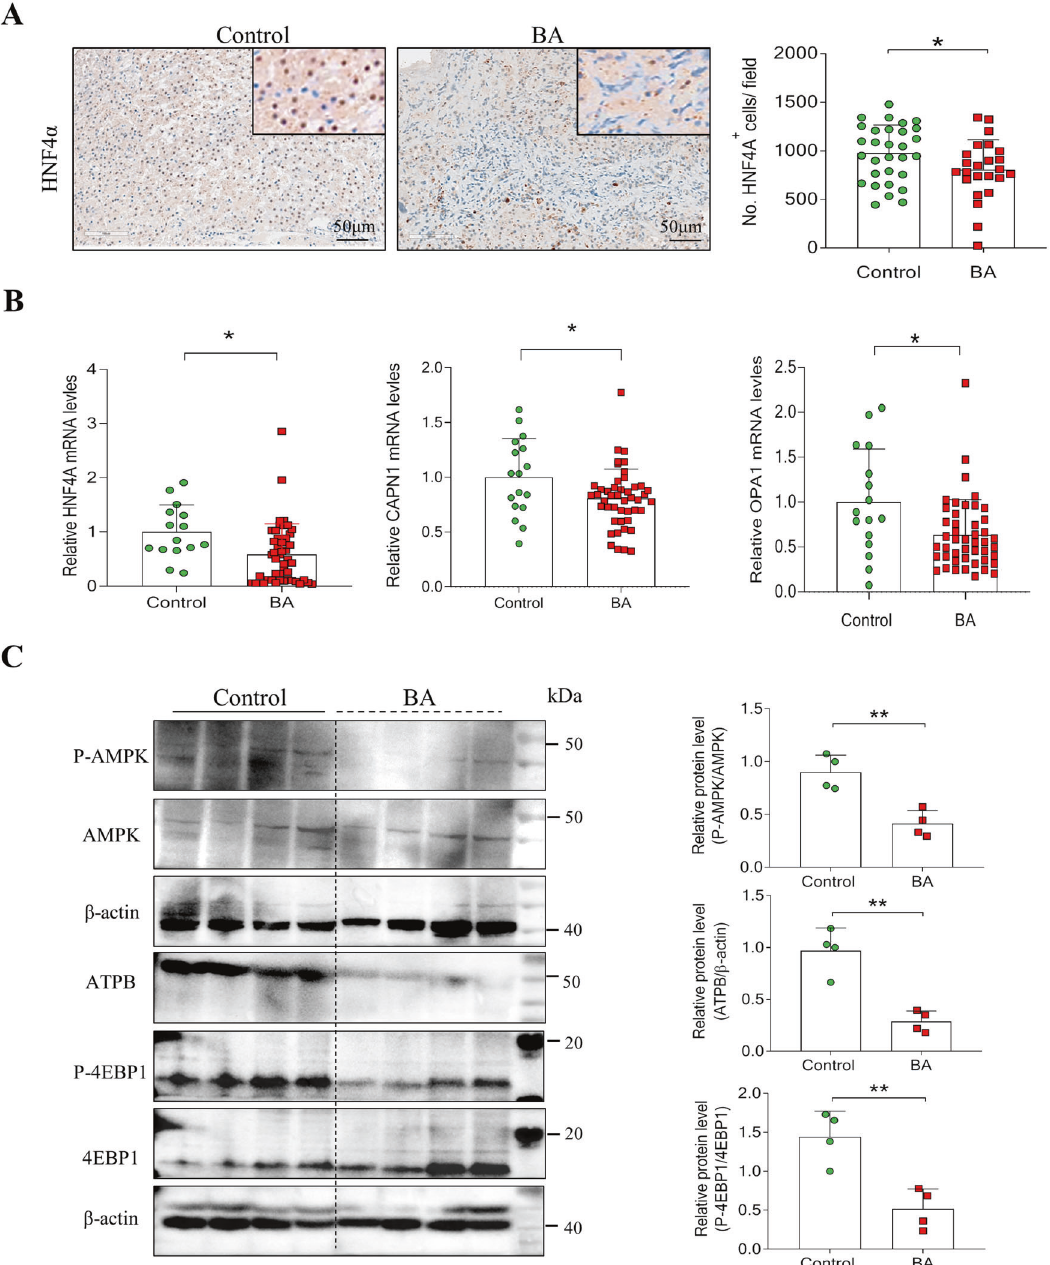
Fig. 3 Mitochondrial respiration and ATP synthase decreased in BA patients. A Representative immunohistochemistry (IHC) images of HNF- 4 α in livers of BA patients ( n = 6) and controls ( n = 6). The quanti fi cation of HNF-4 α + cells. B The relative expression of HNF4A, CAPN1, and OPA1 mRNAs in the liver of BA and controls. C Representative images of western blotting (WB) for P-AMPK, AMPK, ATPB, P-4EBP1, and 4EBP1 and quanti fi cation of WB. Statistical signi fi cance: * p <